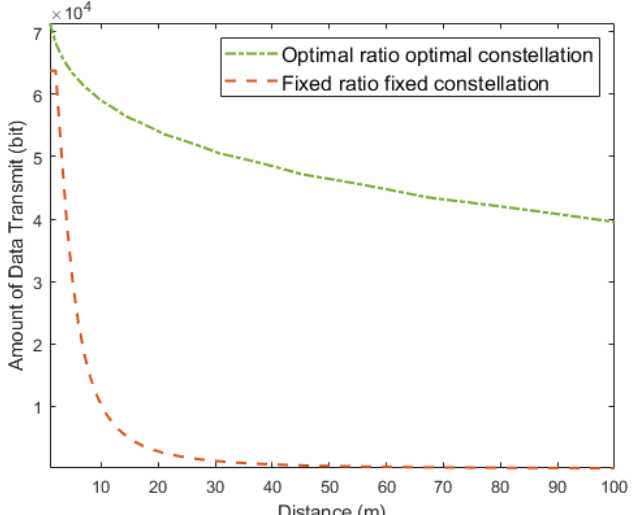
Figure 7. Optimized time ratio-optimized constellation size versus fixed time ration fixed constella- tion size.